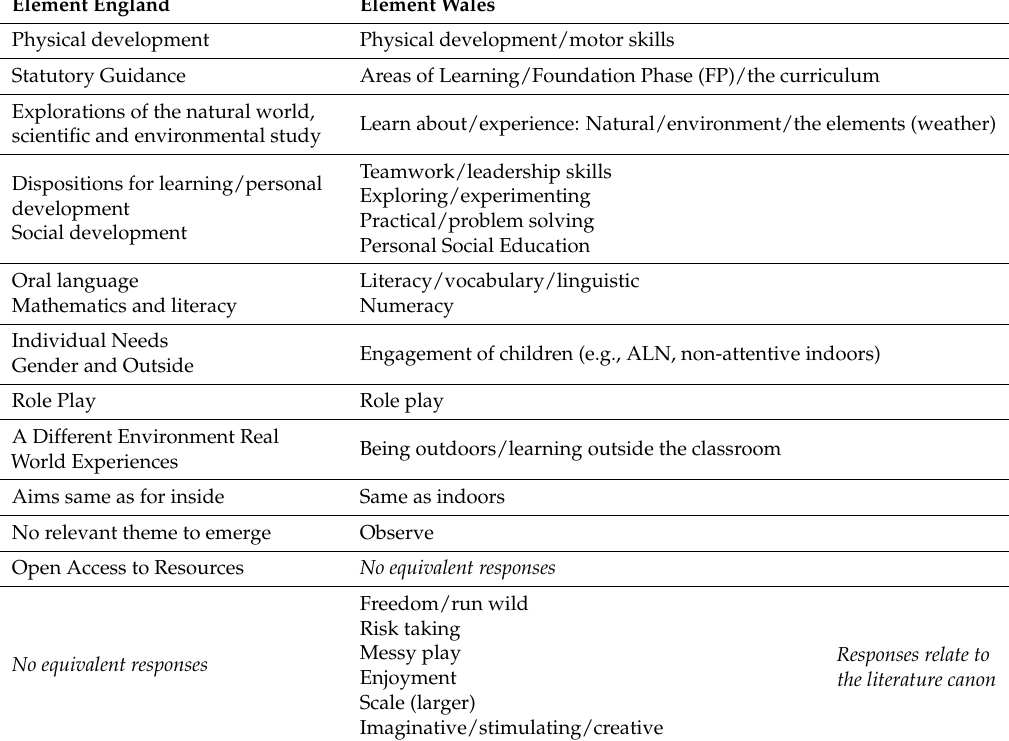
Table B1. Equivalent coding for elements between the